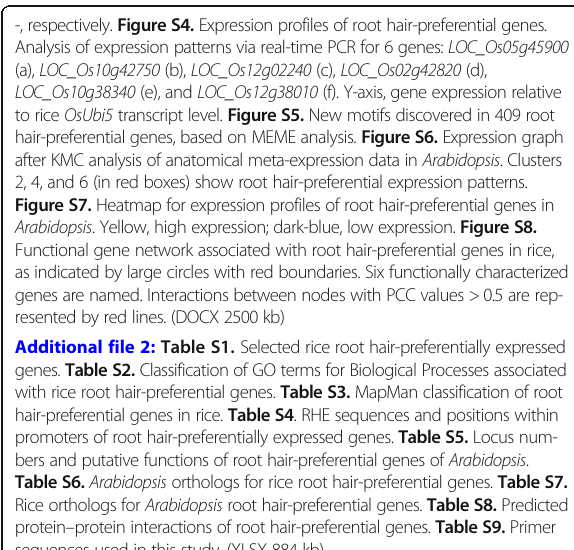
Table S6. Arabidopsis orthologs for rice root hair-preferential genes. Table S7. Rice orthologs for Arabidopsis root hair-preferential genes. Table S8. Predicted protein – protein interactions of root hair-preferential genes. Table S9. Primer sequences used in this study. (XLSX 884